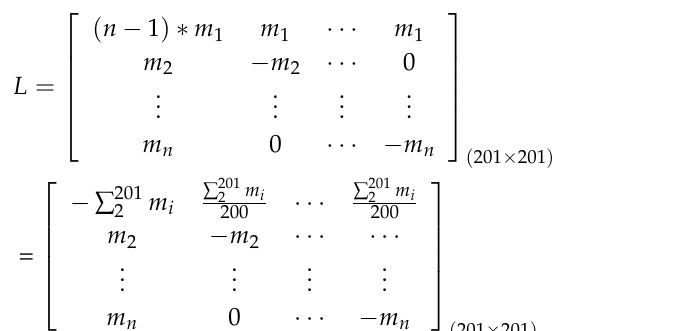
Figure 20. The negative correlation between DG number and critical coupling strength is still evident.